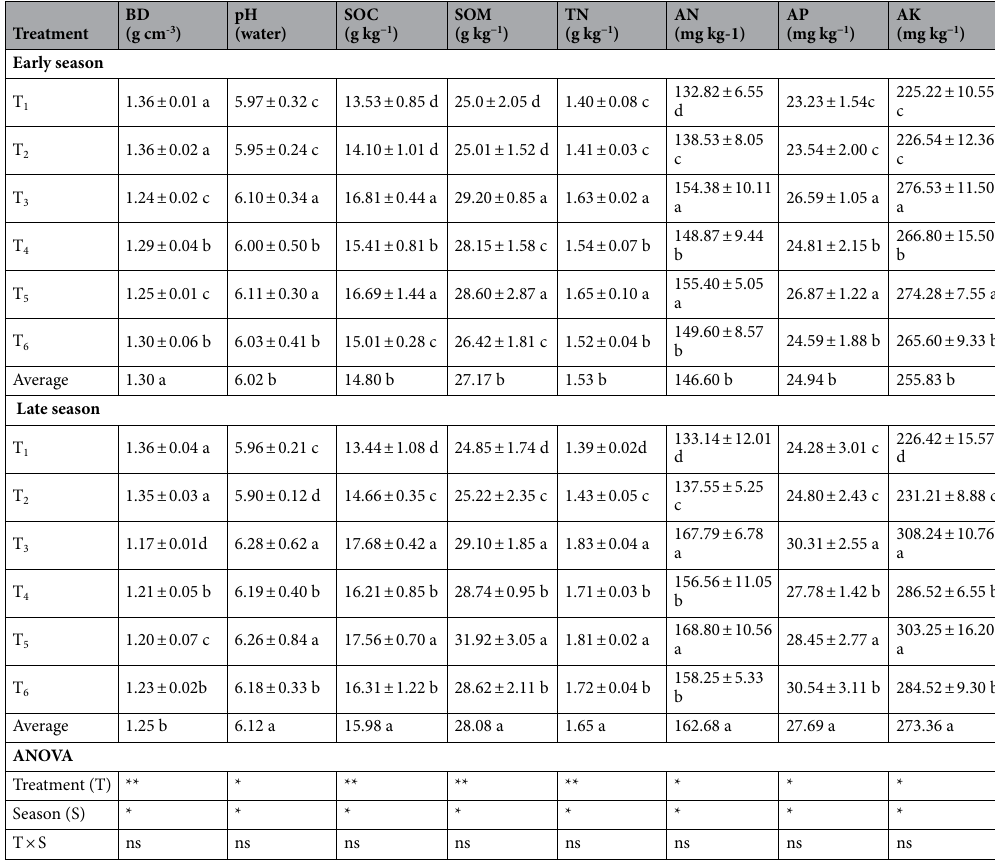
Table 1. Changes in soil physical and checmial properties under the combined organic and inorganic N fertilization. Note: T within column, are not significantly different at p ≤ 0.05. Mean values (n = 3) ± SE. ns: non significant, * p < 0.05, ** p <